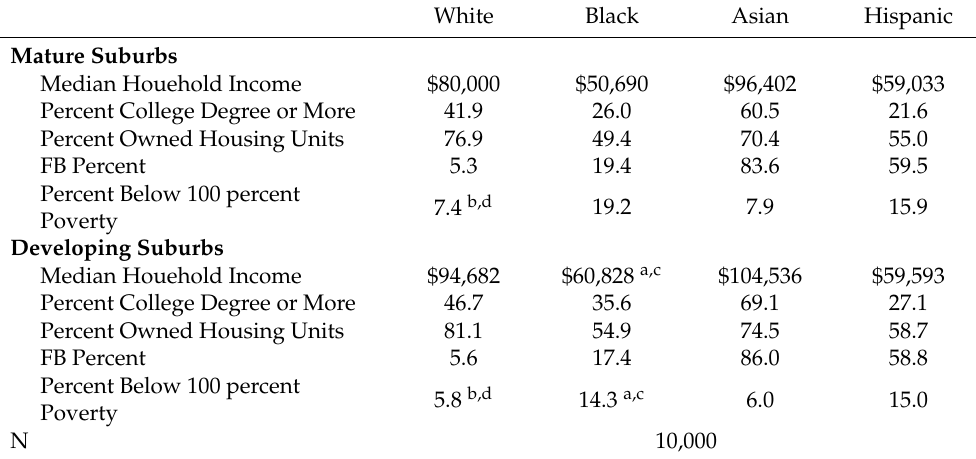
Table 2. Selected Mature and Developing Suburban Characteristics of Where Each Group